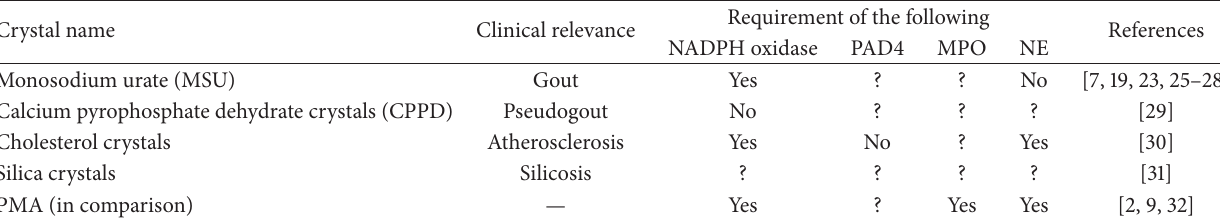
Table 1: Microcrystals that trigger NET